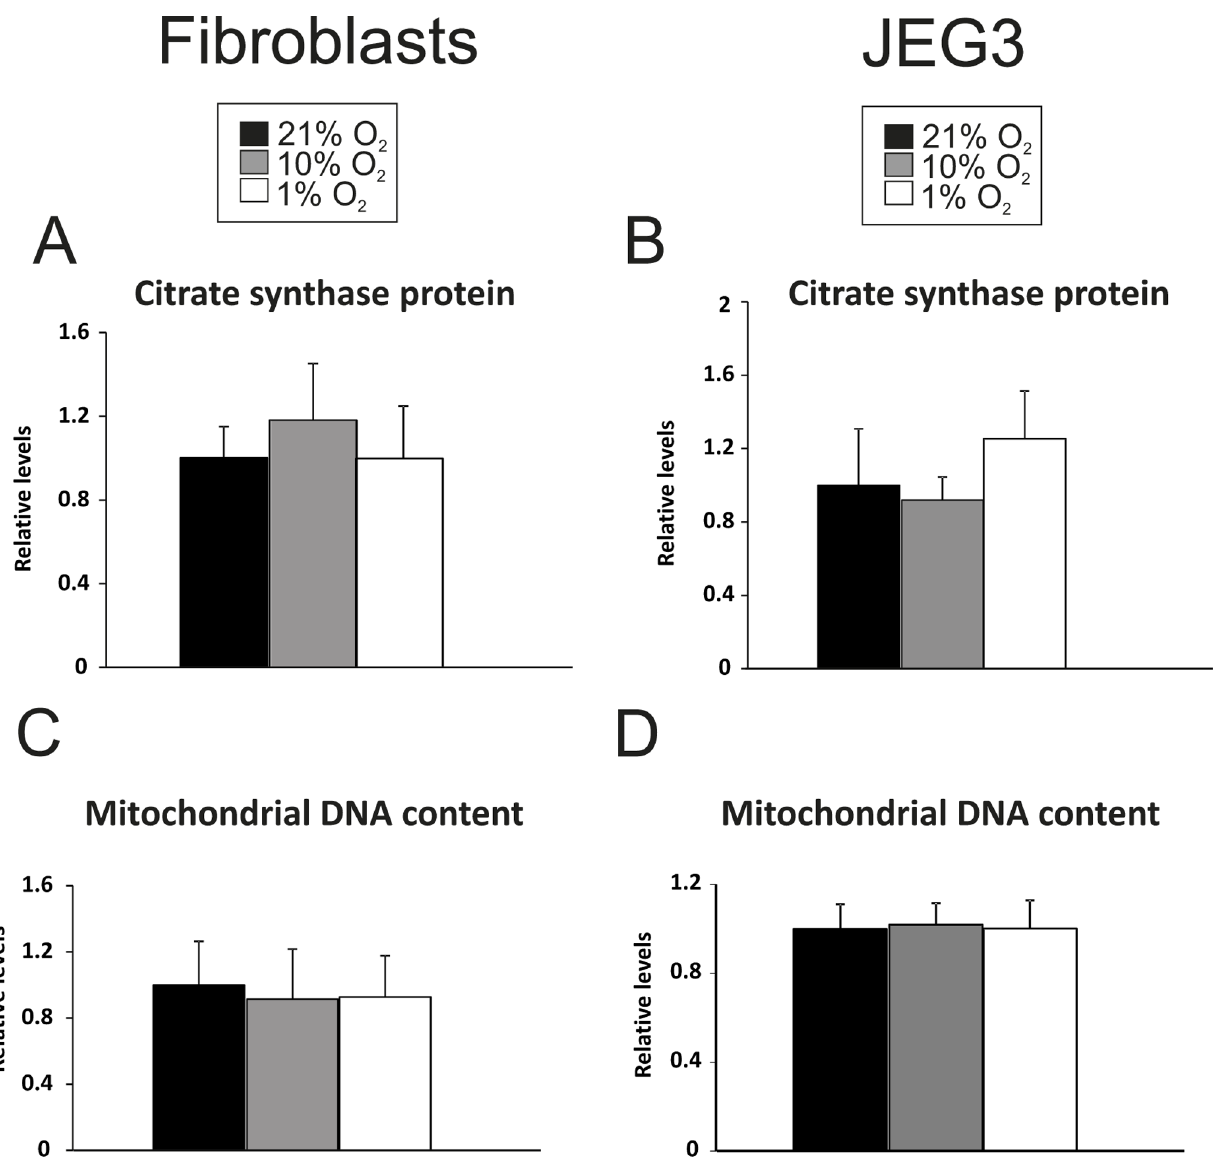
Figure 2. Citrate synthase protein levels and mitochondrial DNA copy number in placental fibroblasts and JEG3 cells. A, B) Protein levels of citrate synthase in A) fibroblasts and in B) JEG3 cells. C, D) Mitochondrial DNA content in C) fibroblasts and D) JEG3. Minimum of four biological replicates per cell type for each condition were performed.